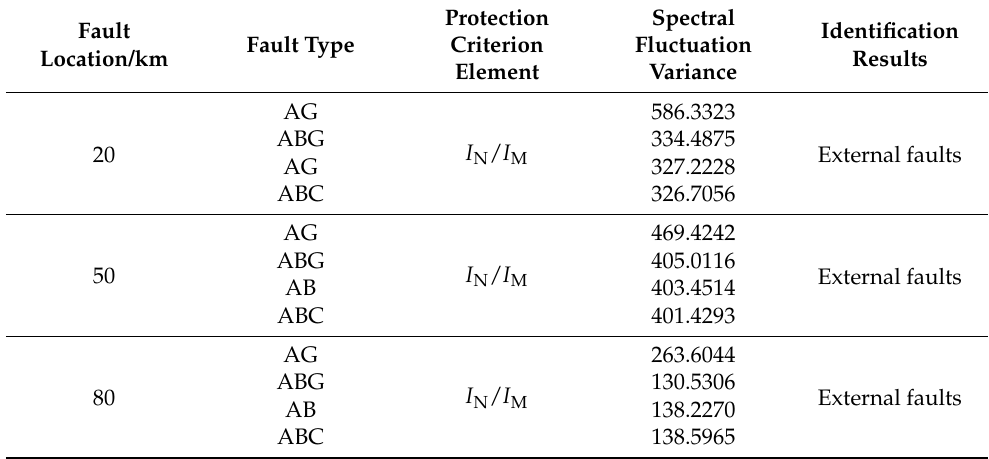
Table 4. Spectrum fluctuation variance in fault current ratios when different types of external faults